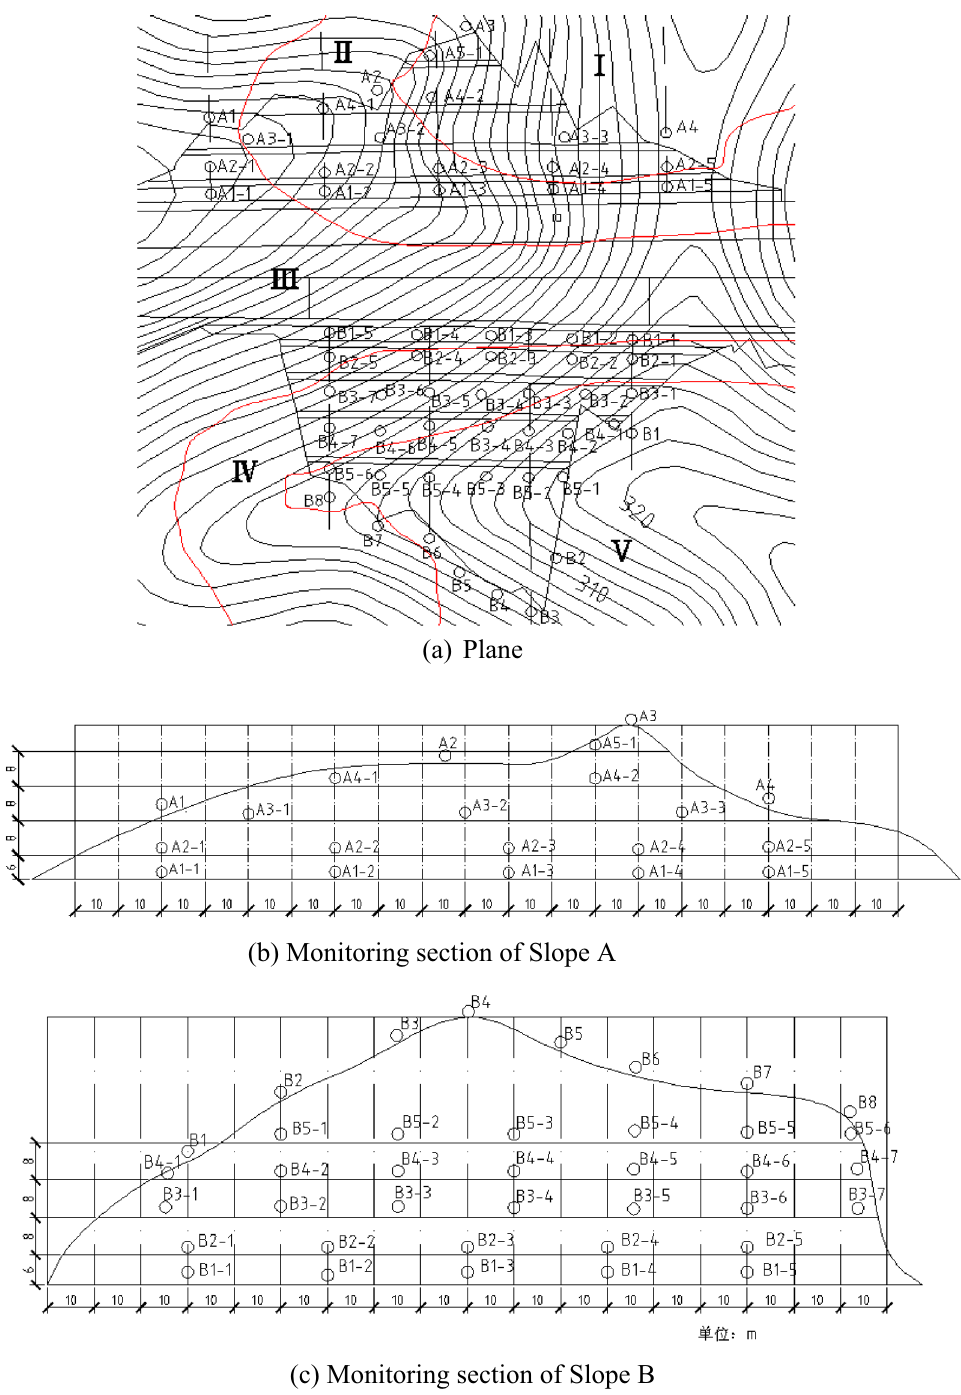
Figure 24. Optimized monitoring arrangement considering 3D